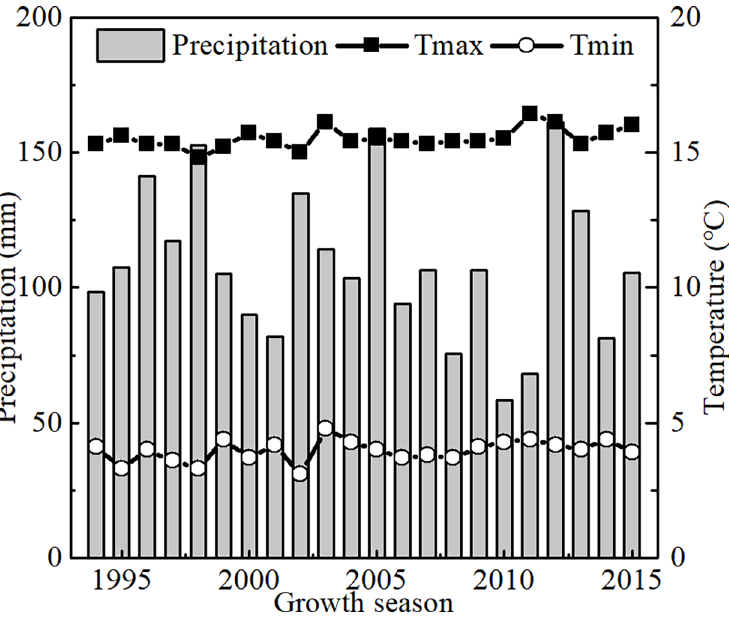
Fig 1. Distribution of precipitation, maximum (Tmax) and minimum temperature (Tmin) at Gaocheng, over 22 growth season.